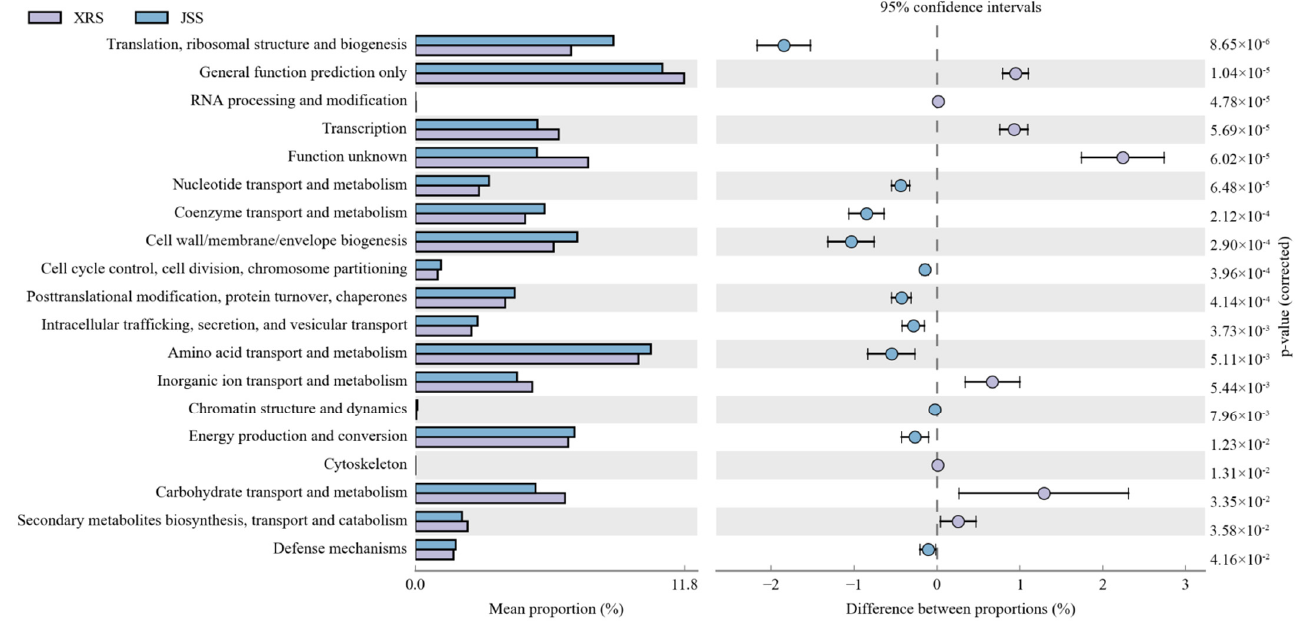
Figure 9. High relative abundance in COG functional annotation. Different colors mean different groups. Different functional parts were shown in the figure. JSS: the bulk soil sample; XRS: soil of the P. sibiricum rhizosphere.